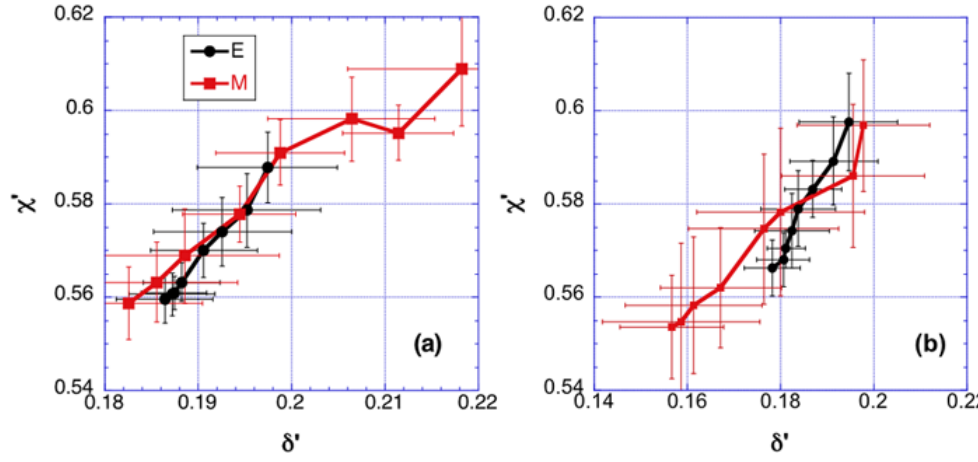
Fig. 5. Median depolarization ratio, δ 0 , as a function of color ratio, χ 0 (a) . As in Fig. 2, colors identify the examined regions E (black) and M (red). (b) is the same as (a) , but for a different dataset from 25 May to 25 June 2008.